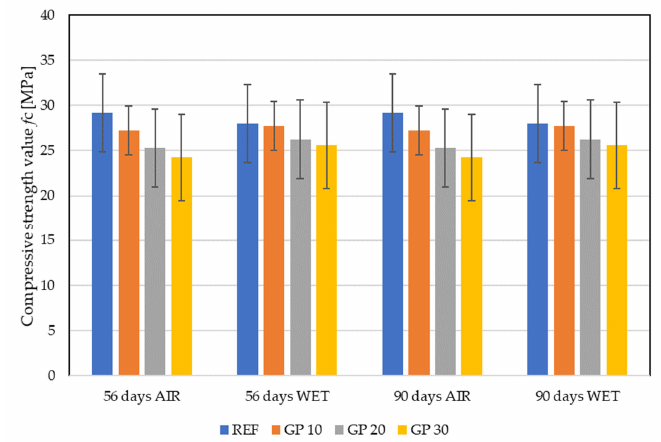
Figure 4. Average compressive strength of the near-surface layer f c